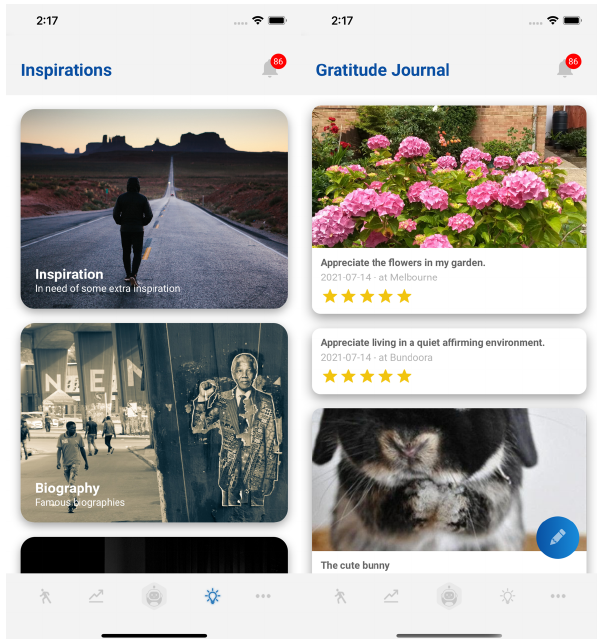
Figure 4. Recurrent emotional support provided by the gratitude journal and motivational content feature of the